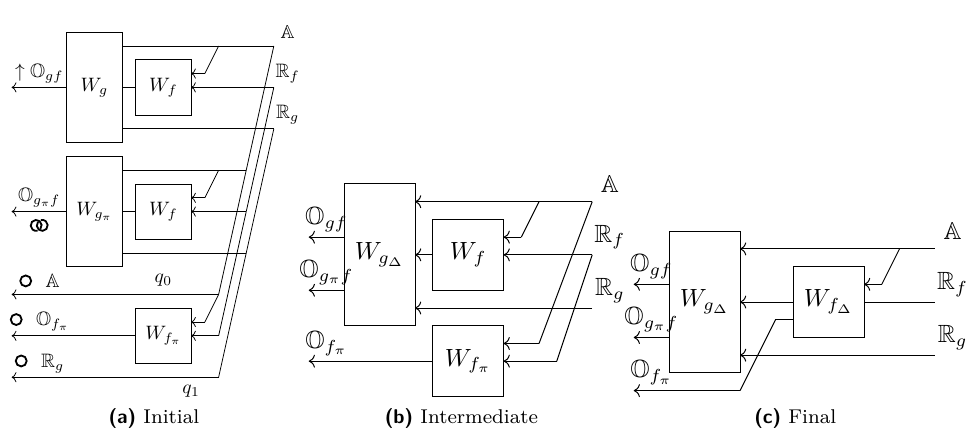
Figure 21: Pruning of the a vulnerability profile considering equivalences and dominance relations of the correlation matrix